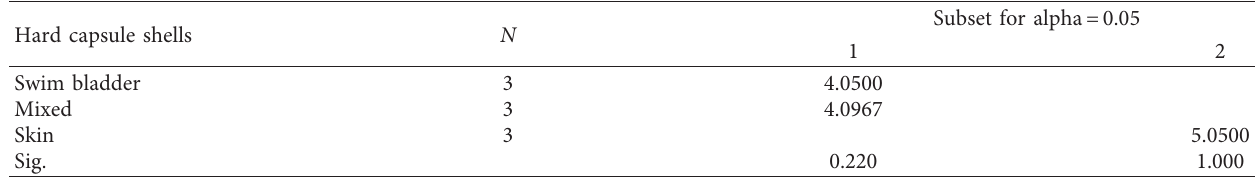
Figure 3: Kolmogorov–Smirnov plot of disintegration time of the mixed gelatin capsule. Table 4: Duncan’s test of disintegration time of hard capsule